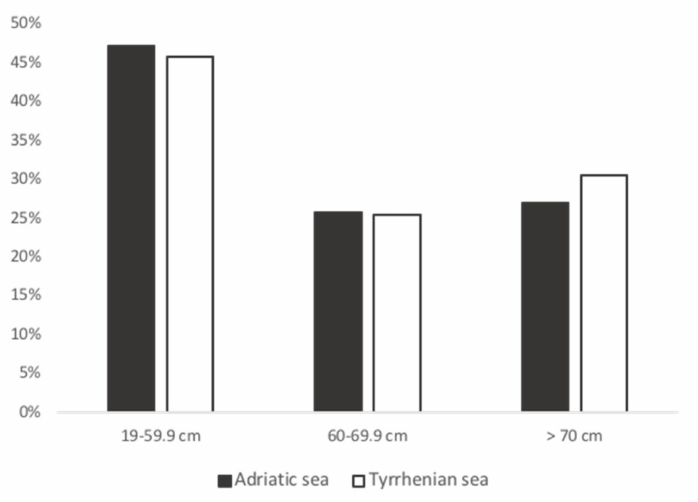
Figure 1. CCL frequency histogram in the Adriatic ( n = 89) and Tyrrhenian seas ( n = 61). A 19–59.9 cm CCL: n = 42 (Adriatic Sea), n = 27 (Tyrrhenian Sea); 60–69.9 cm CCL: n = 23 (Adriatic Sea), n = 15 (Tyrrhenian Sea); >70 cm CCL: n = 24 (Adriatic Sea), n = 18 (Tyrrhenian